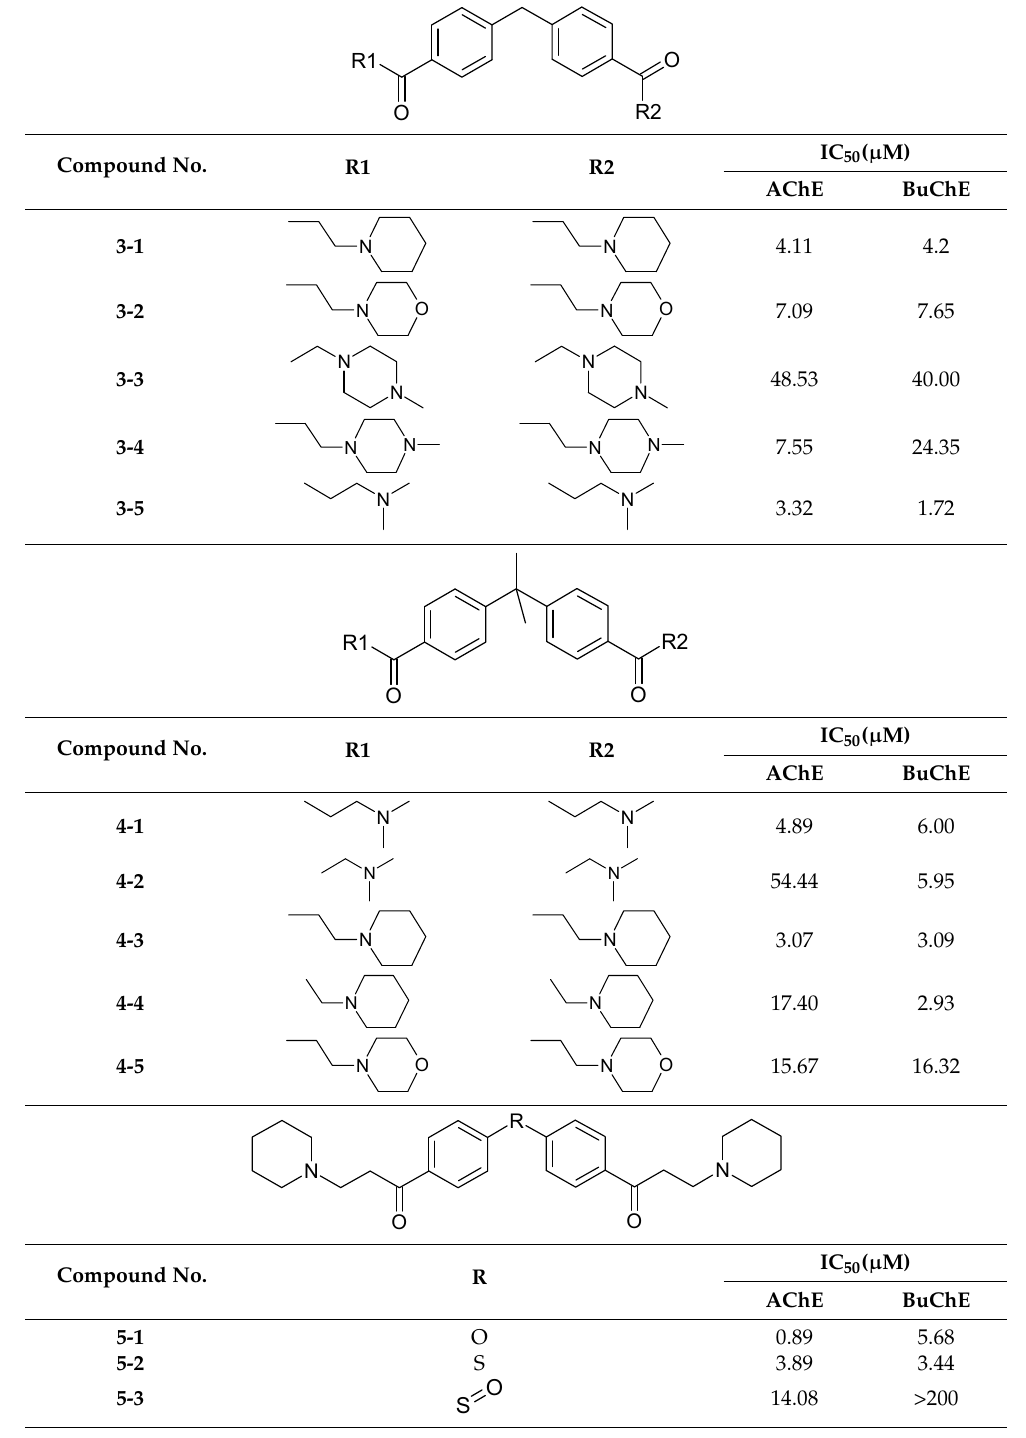
Table 1. The chemical structures and biological activities of DL0410 and its 50 derivatives as AChE and BuChE inhibitors.